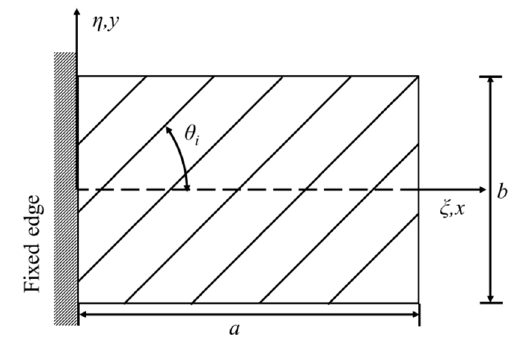
Figure 1. Configuration of composite cantilever Figure 1. Con fi guration of composite cantilever plate.